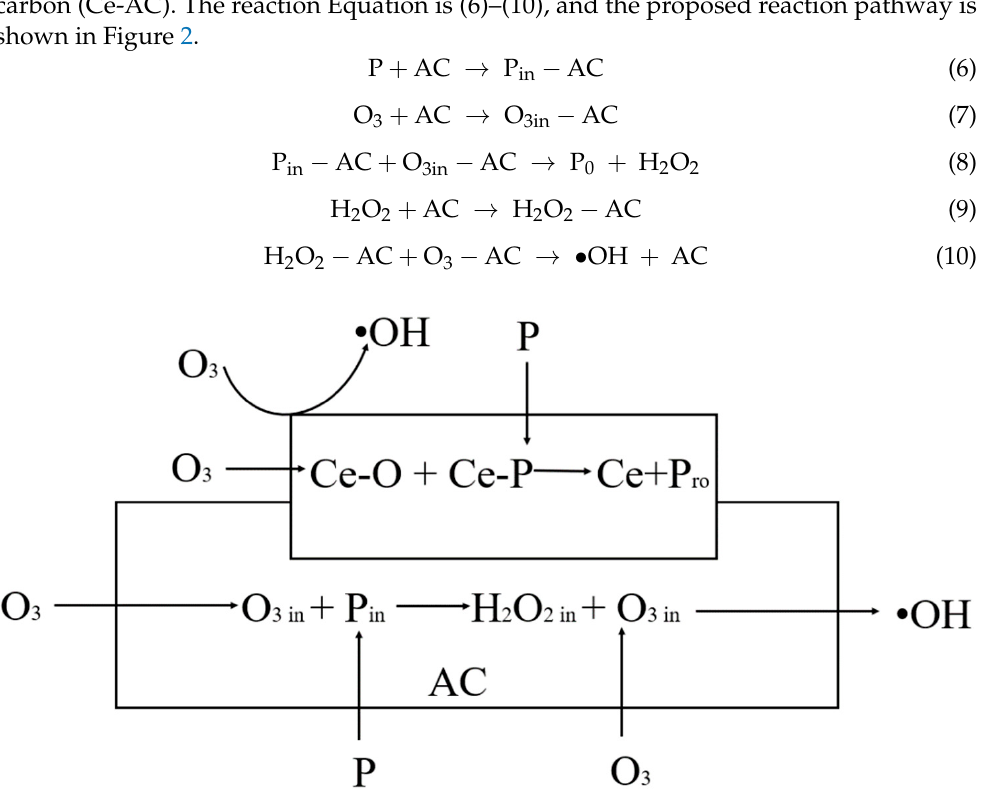
Figure 2. The proposed reaction pathway of catalytic ozonation by Ce-AC (based on [7]).